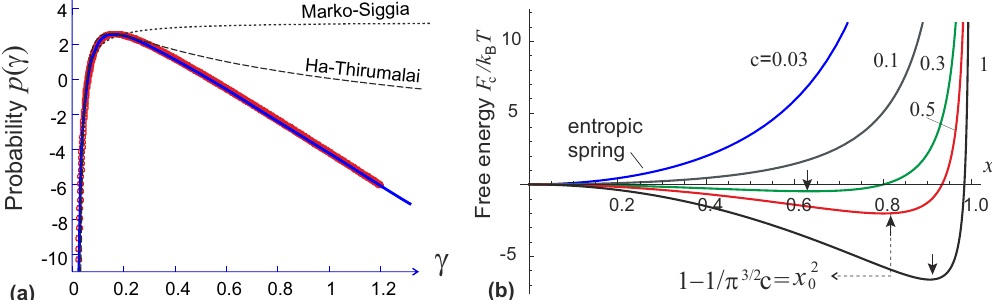
Figure 2. ( a ) The result of numerical calculation of the integral Equation (6) plotted as a universal function of parameter γ . The solid line drawn through these points is the analytical expression Equation (7); ( b ) Plots of the filament free energy, Equation (8), for several vaues of stiffness parameter c labelled on the plot. The arrows point at the force-free filament extension x 0 ( c ) that occur for stiffer filaments with c > π − 3/2